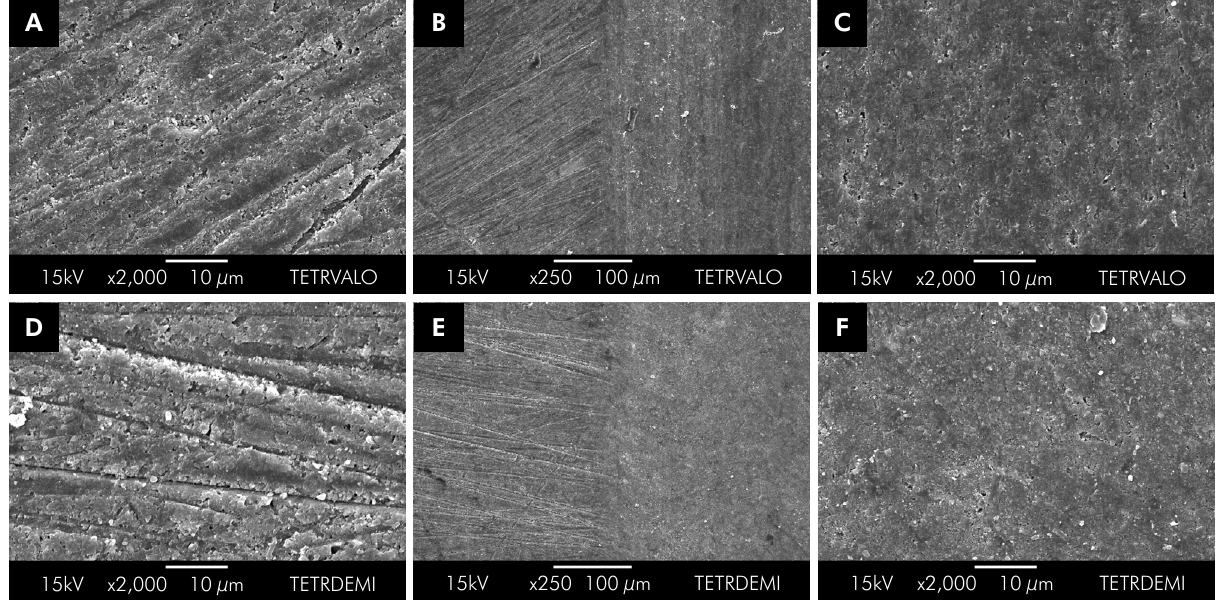
Figure 5. SEM images (250 x and 2000 x) showing the surfaces (unbrushed/control and brushed sides) of TET. A- unbrushed area, B- border area between unbrushed control and brushed sides and C- brushed area polymerized with Valo. D- unbrushed area, E- border area between unbrushed control and brushed sides, and F- brushed area polymerized with Demi Ultra.